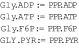
Some of the equivalences required between
Gly and
PPP.